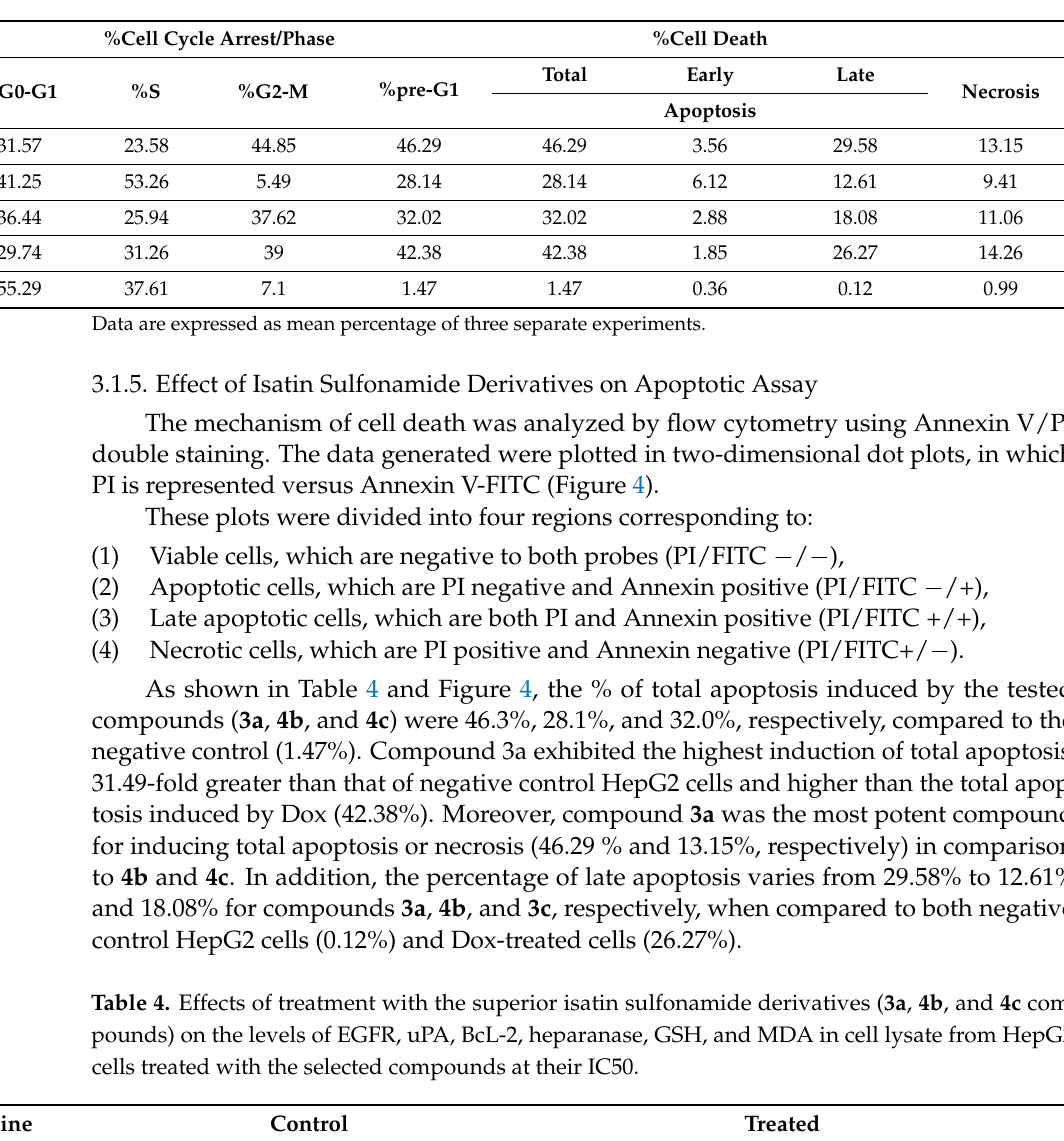
Table 3. Cell cycle analysis using flow cytometry in HepG2 expressed as % of cells in each phase after treatment with isatin sulfonamide tested compounds, 3a , 4b , and 4c , and controls, and Annexin V/FITC apoptotic activity of selected isatin compounds is expressed as % of cell death induction.